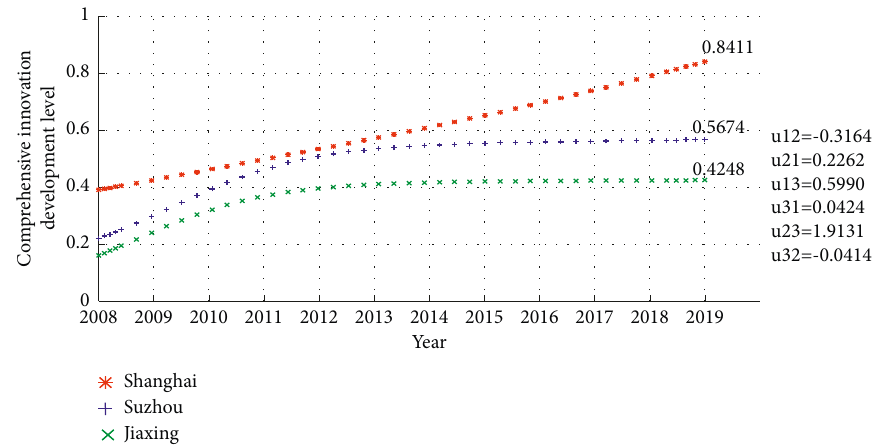
Figure 3: Evolution trend of comprehensive innovation development level in Shanghai, Suzhou, and